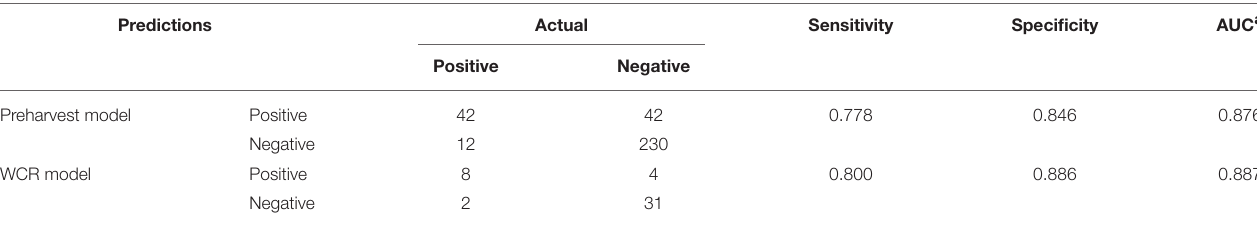
TABLE 6 | Predictive performance of the preharvest and whole carcass rinse (WCR) random forest models. Predictions Actual Sensitivity Positive Negative Preharvest model